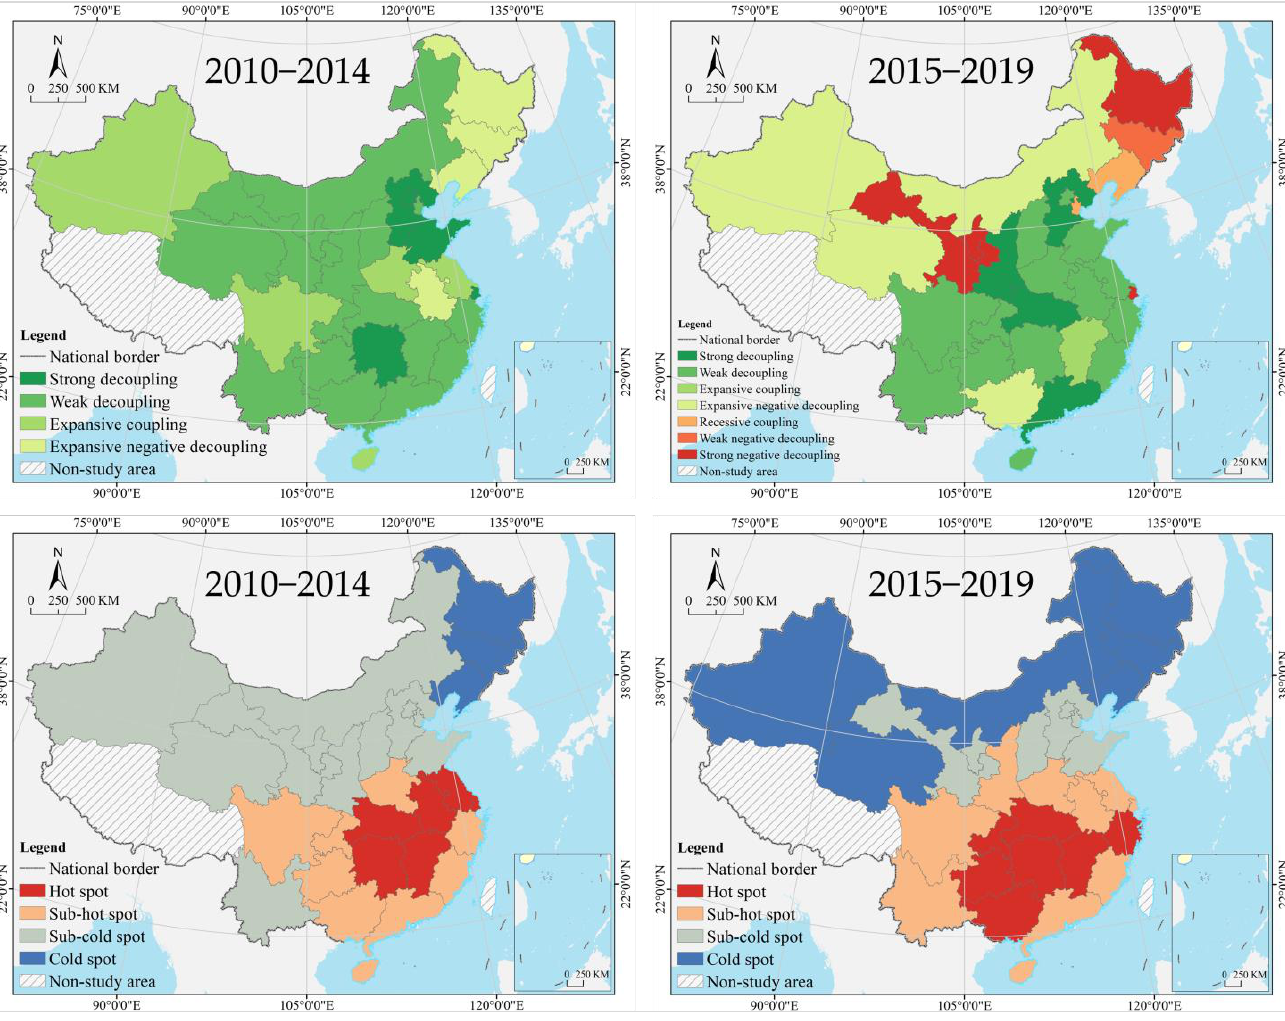
Figure 13. Spatial distribution and gathering characteristics of decoupling types between ECA and added value.